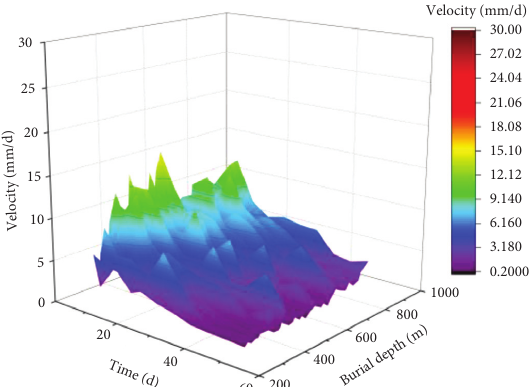
Figure 15: Deformation velocity of ribs.